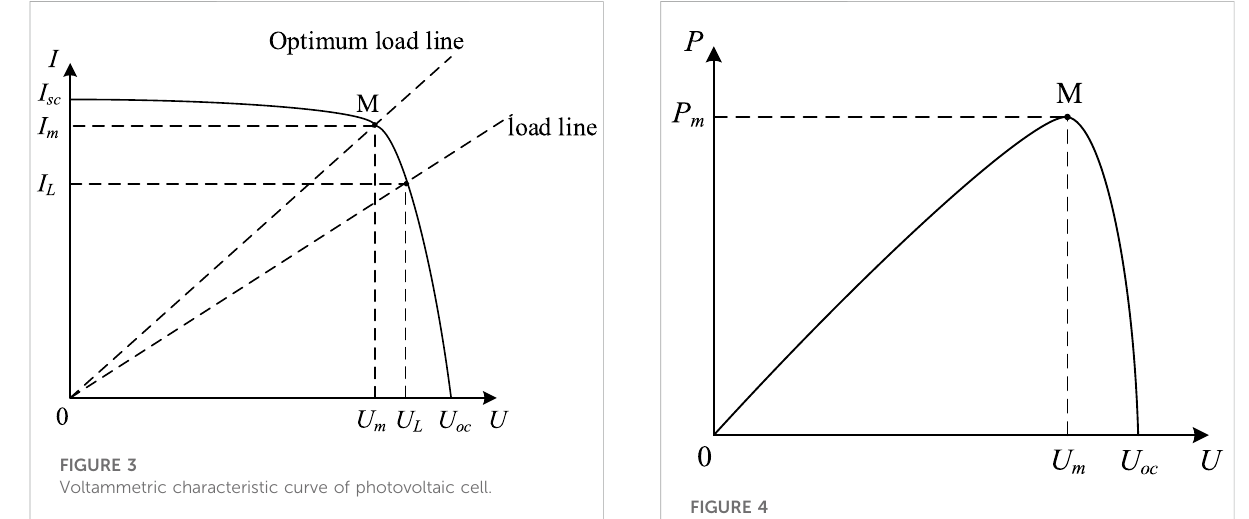
FIGURE 4 Pv cell power-voltage output characteristic